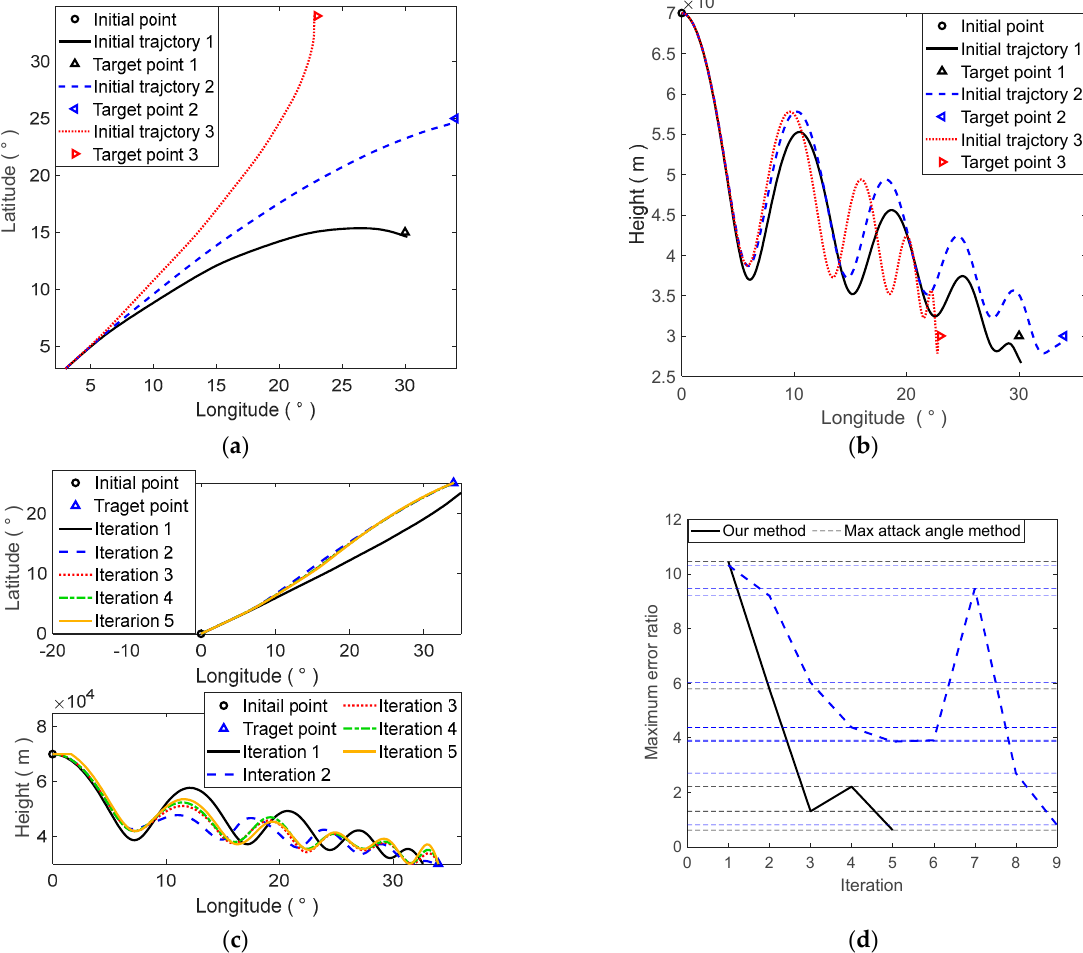
Figure 5. The generated initial trajectories: ( a ) is the lateral effect of trajectory; ( b ) is the longitudinal effect; ( c ) is the iteration change of the optimized trajectories; ( d ) is the comparison between our method and max attack angle method. satisfy the longitudinal guidance at the same time.